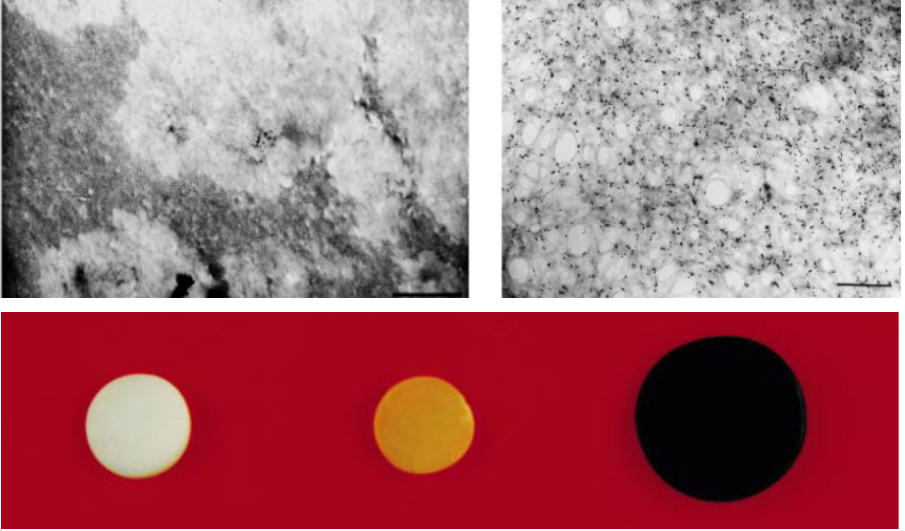
Figure 29. TEM images for sample sections: ( a ) 3.5 wt% Fe-loaded polystyrene (PS)-polyacrylate gel prior to reaction with NaOH (scale bar = 500 nm); ( b ) after reaction with NaOH, showing the distribution and uniformity of the magnetite nanocrystallites (scale bar = 500 nm); and ( c ) synthesis of the magnetic sponge-like copolymer gel. Comparison between: ( c , left ) an unloaded polymer gel; ( c , middle ) after exposure to a 0.2 M Fe 2+ solution; and ( c , right ) after reaction with NaOH. The gels imaged with a digital camera on ( c ) are in the swollen state. Reprinted with permission from